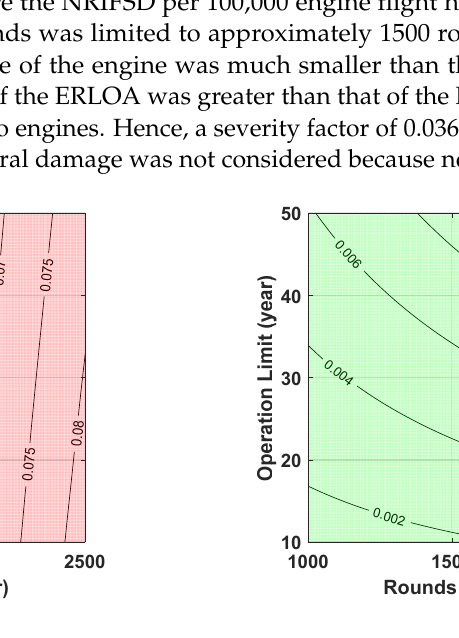
Figure 15. Contour plots of projected risks of engine failure caused by aircraft self ‐ collision. ( a ) NRIFSD per 100,000 engine flight hours and ( b ) ERLOA over remaining life of engine.